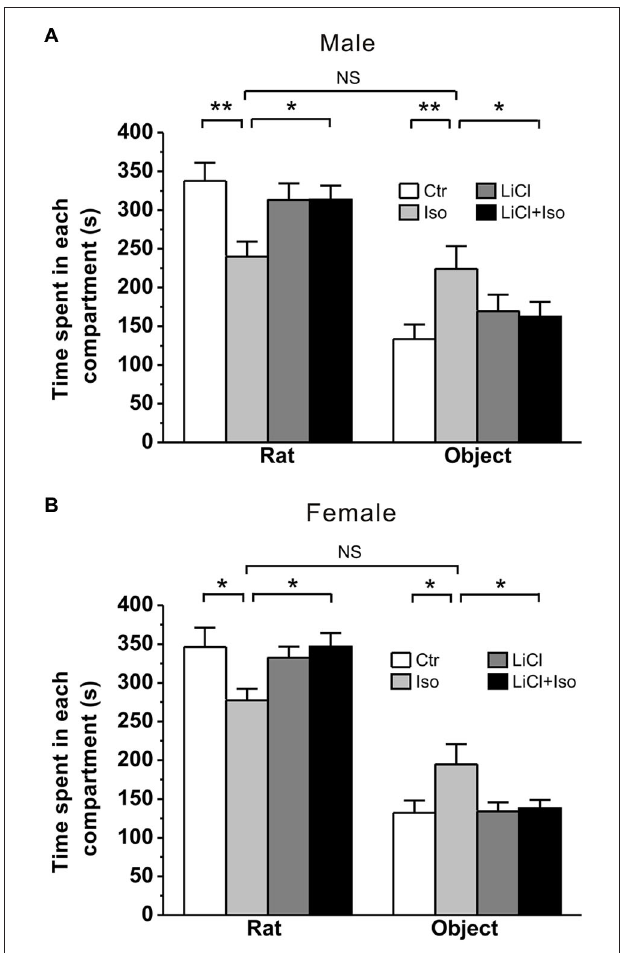
FIGURE 1 | Lithium rescues the deficit of social interaction in neonatal isolation rats . Both male (A) and female (B) rats subjected to maternal separation for 1 h/day from PND 1–9 exhibit remarkably more time in object’s compartment and less time in stranger rat’s compartment during social interaction test compared to normal reared controls. Lithium injection immediately after daily isolation recovers the impairment of social interaction behavior in both male (A) and female (B) . Two-way ANOVA analysis was used in this experiment. For isolated male rats in stranger rat’s compartment: treatment × drug, F ( 1,76 ) = 5.588, P < 0.05; treatment, F ( 1,76 ) = 5.515, P < 0.05; drug, F ( 1,76 ) = 1.403, P > 0.05. For isolated female rats in stranger rat’s compartment: treatment × drug, F ( 1,76 ) = 5.111, P < 0.05; treatment, F ( 1,76 ) = 5.179, P < 0.05; drug, F ( 1,76 ) = 2.236, P >